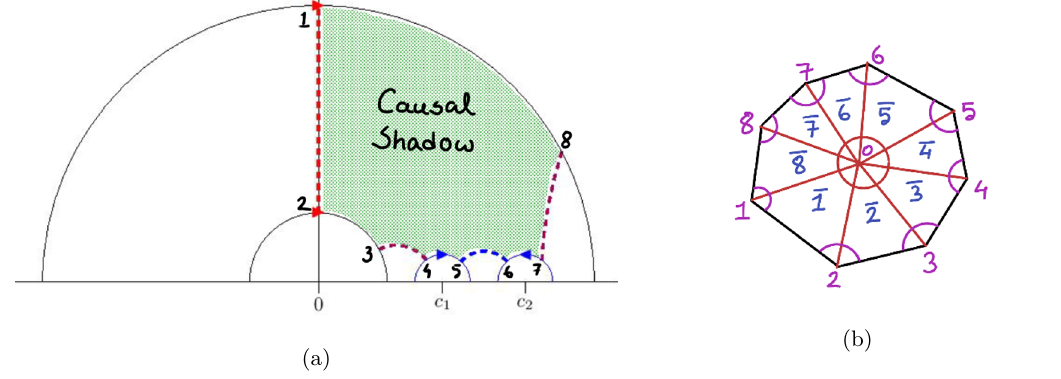
Figure 9. Hyperbolic octagon and Causal Shadow in three-boundary wormhole